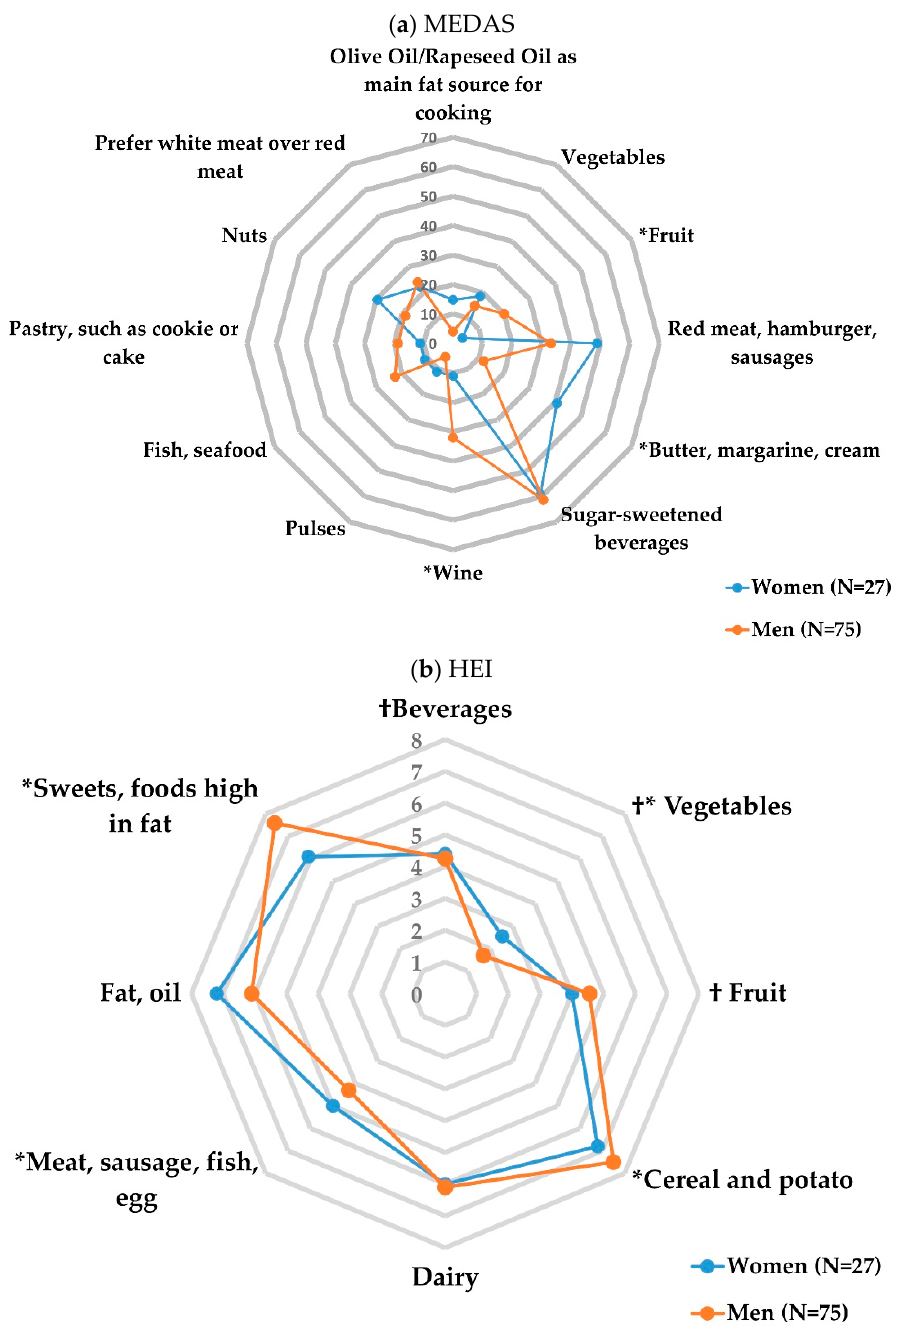
Figure 1. Sex differences in the food items of the Mediterranean Diet Adherence Screener (MEDAS) and the Healthy Eating index (HEI). Dietary patterns of men (N = 75) and women (N = 27) were determined according to average scores achieved for items in the Mediterranean Diet Adherence Screener (MEDAS) and items in the Healthy Eating Index (HEI). For MEDAS, the category “olive oil, rapeseed oil” was excluded as no participant scored it. Scores are presented in percentages for MEDAS and as the average median for items in the Healthy Eating Index (HEI). The scores ranged within 0–10 or 0–20 points depending on the item. † maximum points downscaled from 20 to 10 points. * p < 0.05 for significance. Detailed numerical results are presented in Supplementary Table S2 for MEDAS and Supplementary Table S3 for HEI.